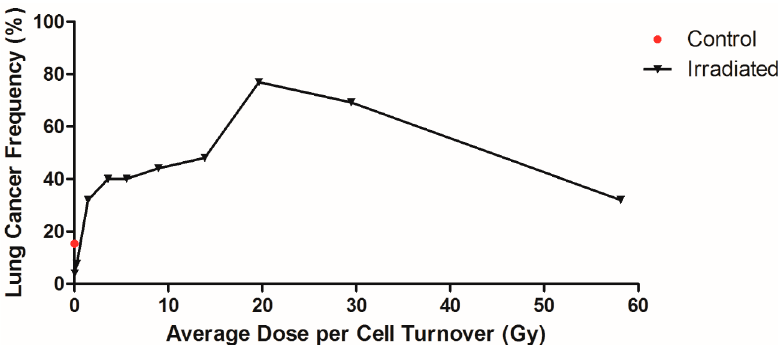
Figure 2. Lung cancer frequency of Beagle dogs exposed to radionuclides. Lung cancer frequency of dogs exposed to of 90 Sr, 144 Ce, 91 Y, and 90 Y in fused aluminosilicate particles was plotted against dose per cell turnover. The control dogs were plotted at the zero point with a lung cancer frequency of 15% and exposed dogs were split into 10 groups, 25–26 dogs per group, regardless of radionuclide. Each data point reflects the mean dose/cell turnover and cancer frequency for each group. The highest and lowest dose/cell turnover were not significantly different from control, while all other dose rates had significantly higher cancer frequencies ( p < 0.05).